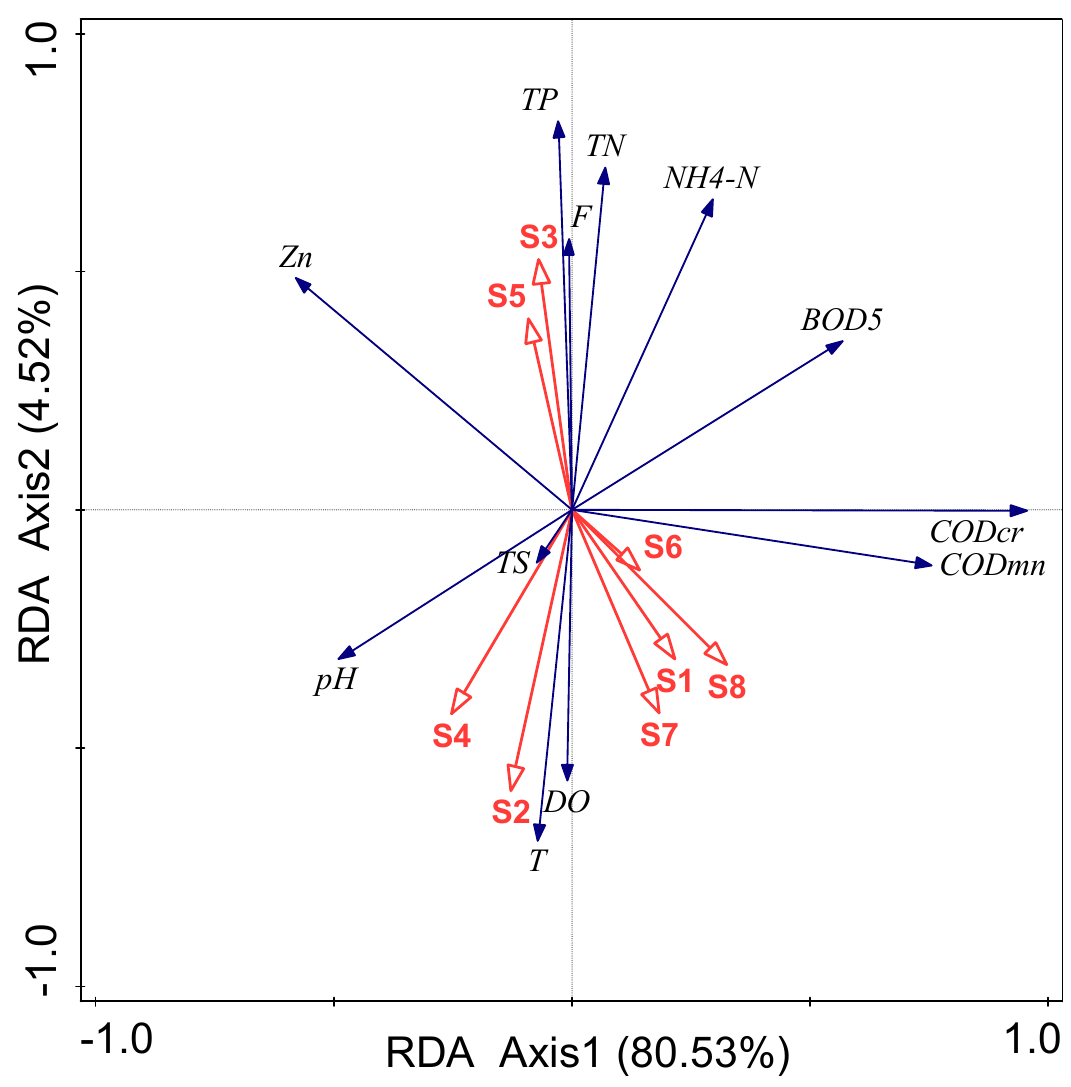
Figure 5. Redundancy analysis (RDA) of water quality parameters and influence factors. S1 is population density, S2 is per capita GDP, S3 is agricultural fertilizer consumption, S4 is drainage pipeline density, S5 is industrial wastewater discharge, S6 is sewage discharge, S7 is built-up area, and S8 is urbanization rate.